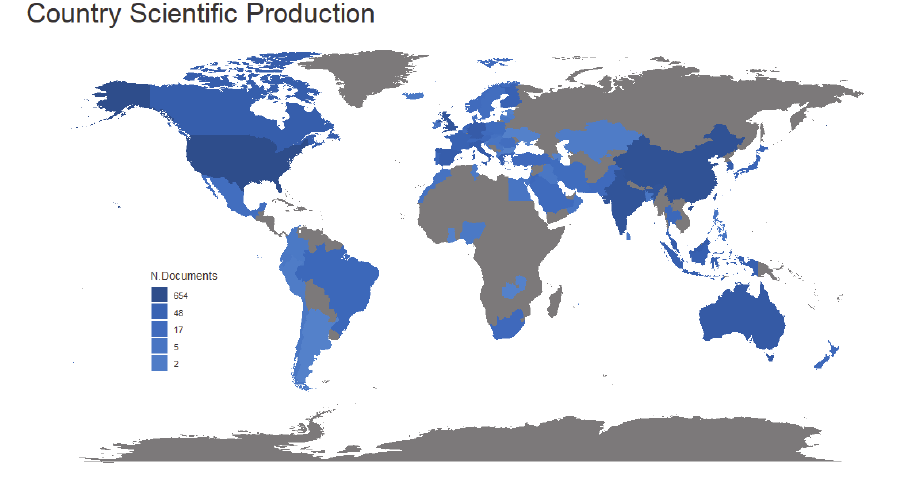
Fig. 10. The frequency of the keywords used in different E-commerce